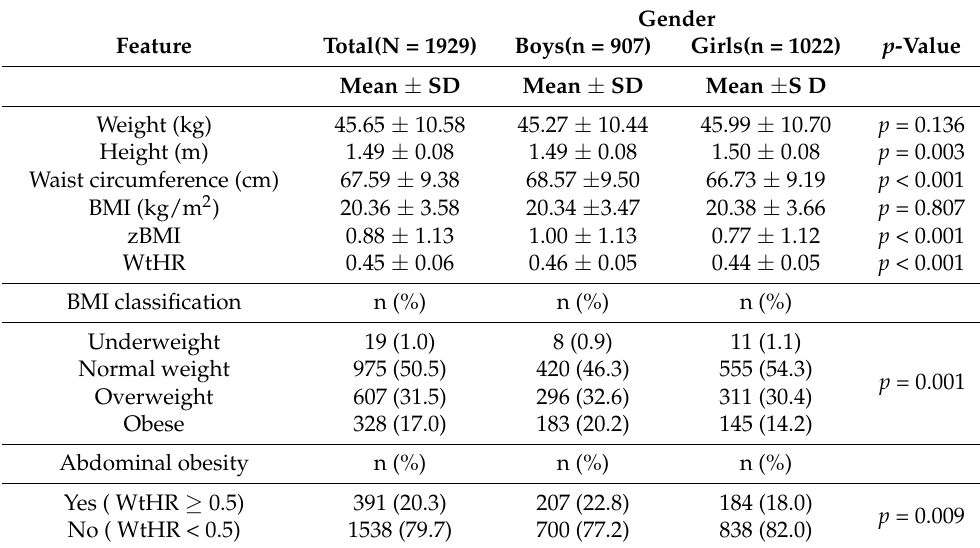
Table 1. Anthropometric characteristics of the sample by